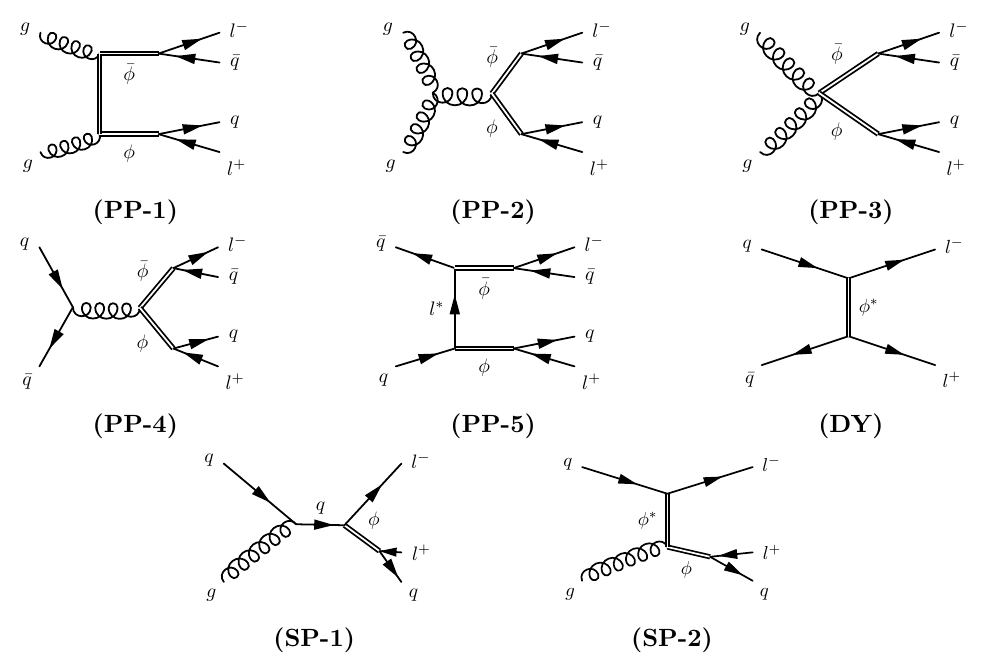
Figure 1. Leading order diagrams for leptoquark pair production pp PP-5), Drell-Yan like dilepton production pp l + l (cid:0) j : (SP-1 and SP-2). The amplitudes PP-1 to PP-4 are proportional to g 2 the DY diagram scale as (cid:21) 2 . Single production diagrams, SP-1 and SP-2, are proportional to g s (cid:21)